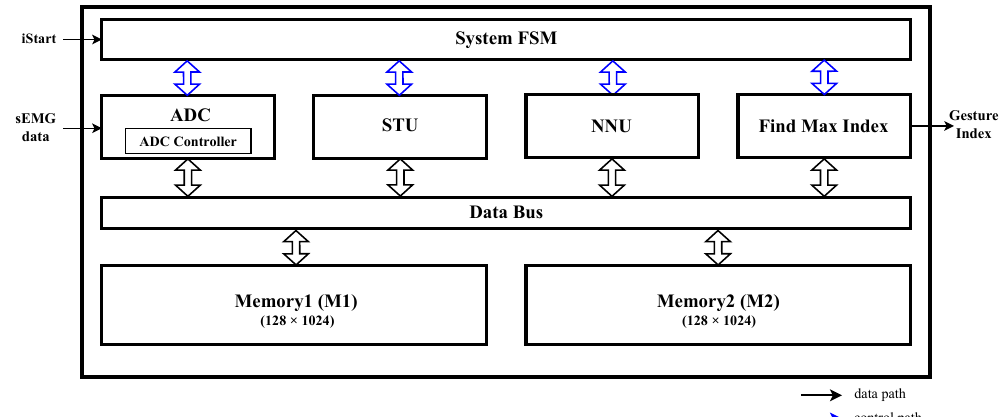
Figure 7. Block diagram of the proposed HGR